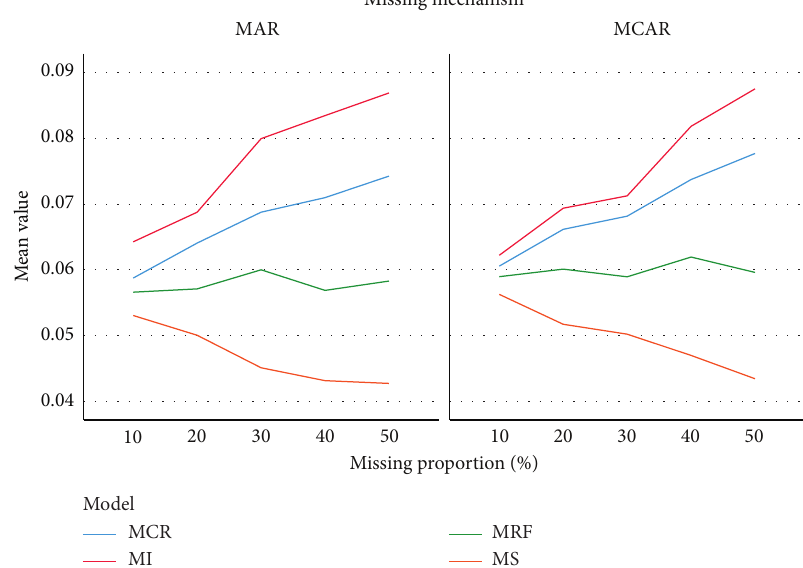
Figure 5: Comparison of the performance of imputation methods for real dataset based on the empirical SE. MAR, missing at random; MCAR, missing completely at random; MCR, multiple imputation by chained equation using classification and regression trees; MRF, multiple imputation by chained equation using random forests; MI, MICE-Interaction method; MS, MICE-Stratified